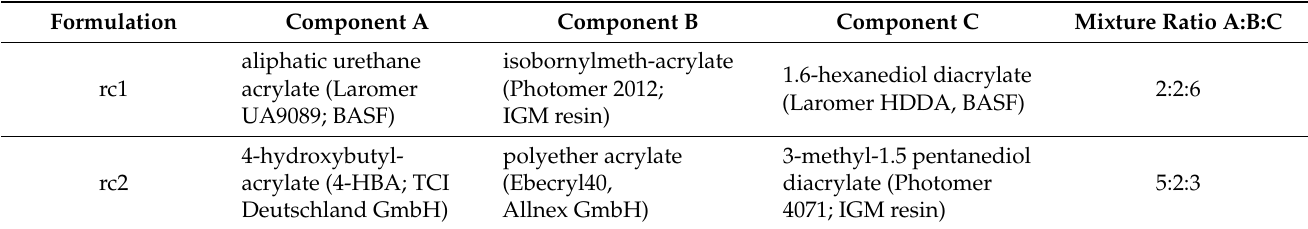
Table 1. Monomers and compositions used for zirconia and titania slurries.